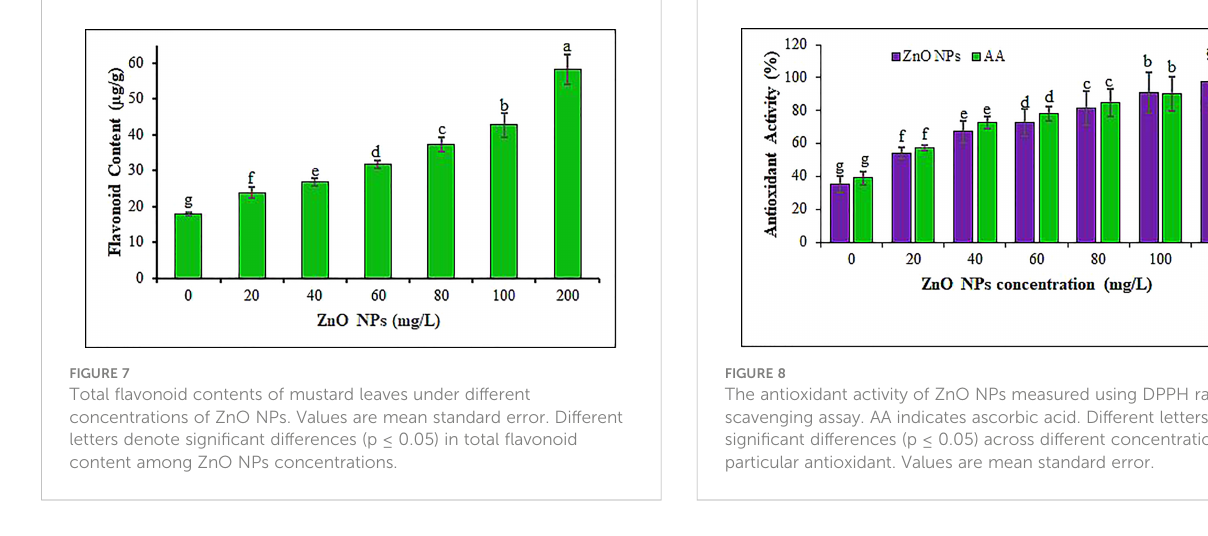
L -1 with TFC of 43 µg g -1 (Figure 7). In support of our results, Zafar